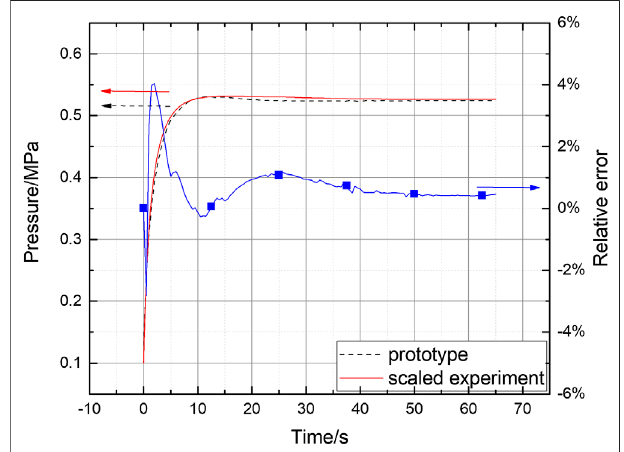
FIGURE 3 | Simulation results of containment